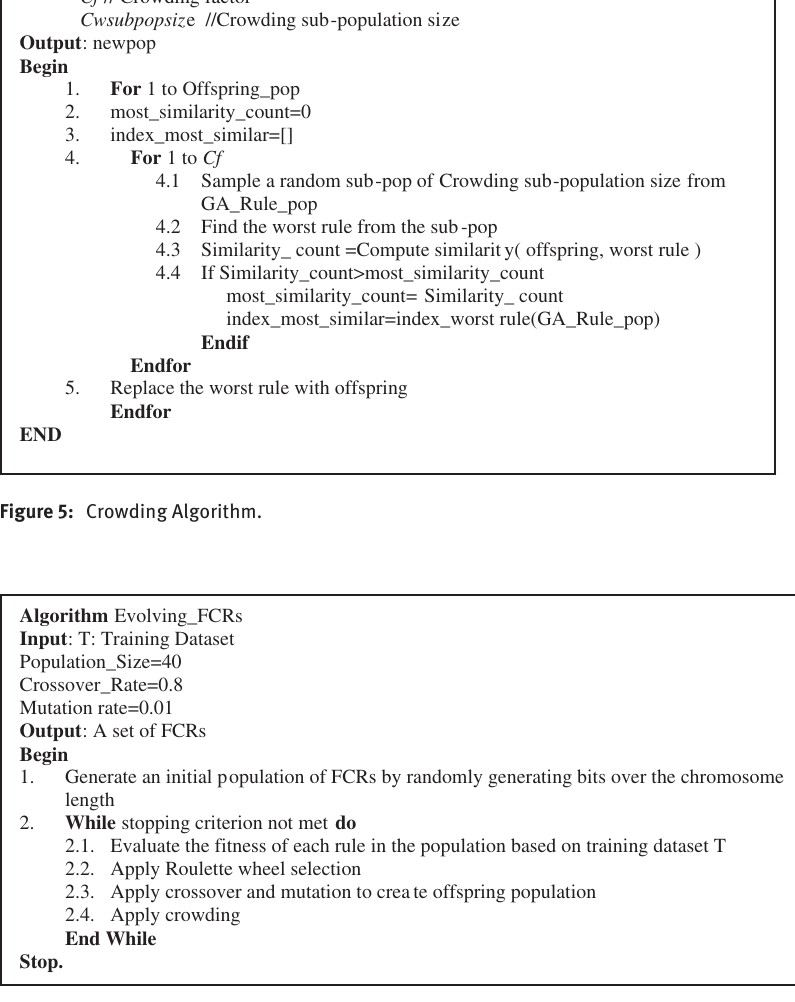
Figure 6: Algorithm for Evolving